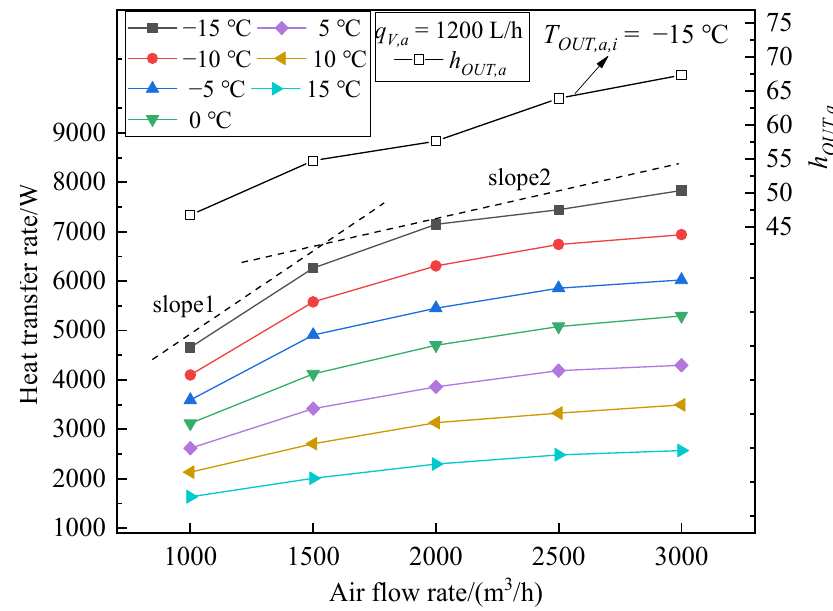
Figure 8. Variation of the heat transfer rate under different air flow rates.